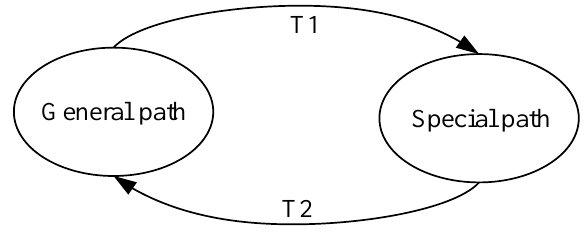
Figure 5. Top-layer state transition.